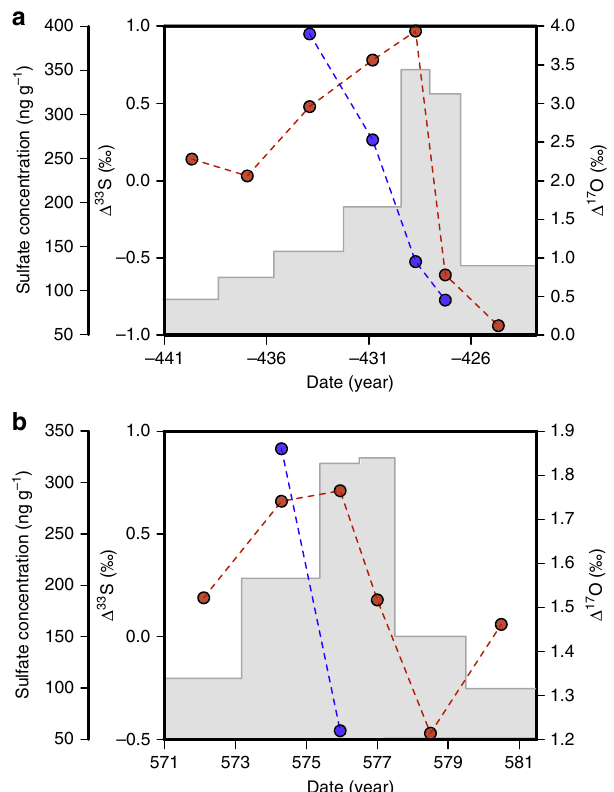
Fig. 3 Anomalies evolution during sulfate deposition after large volcanic eruptions. Δ 17 O (blue line), Δ 33 S (red line) and sulfate concentration evolution (gray shade) as function of time, for two large events: 426 BCE ( a ) and 575 CE ( b ). In both cases, a sharp decrease of Δ 17 O is observed in the volcanic sulfate peak. Dating is provided by Sigl et al.